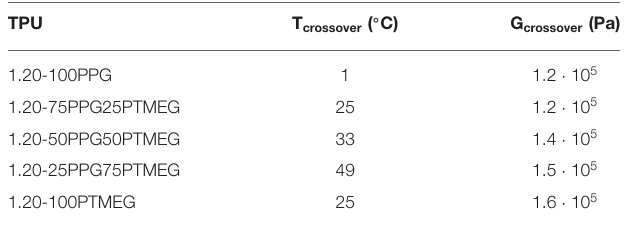
FIGURE 7 | (A) DSC traces (second heating run) and (B) variation of the derivative of the weight as a function of the temperature for TPUs synthesized with different PPG + PTMEG blends. NCO/OH ratio =